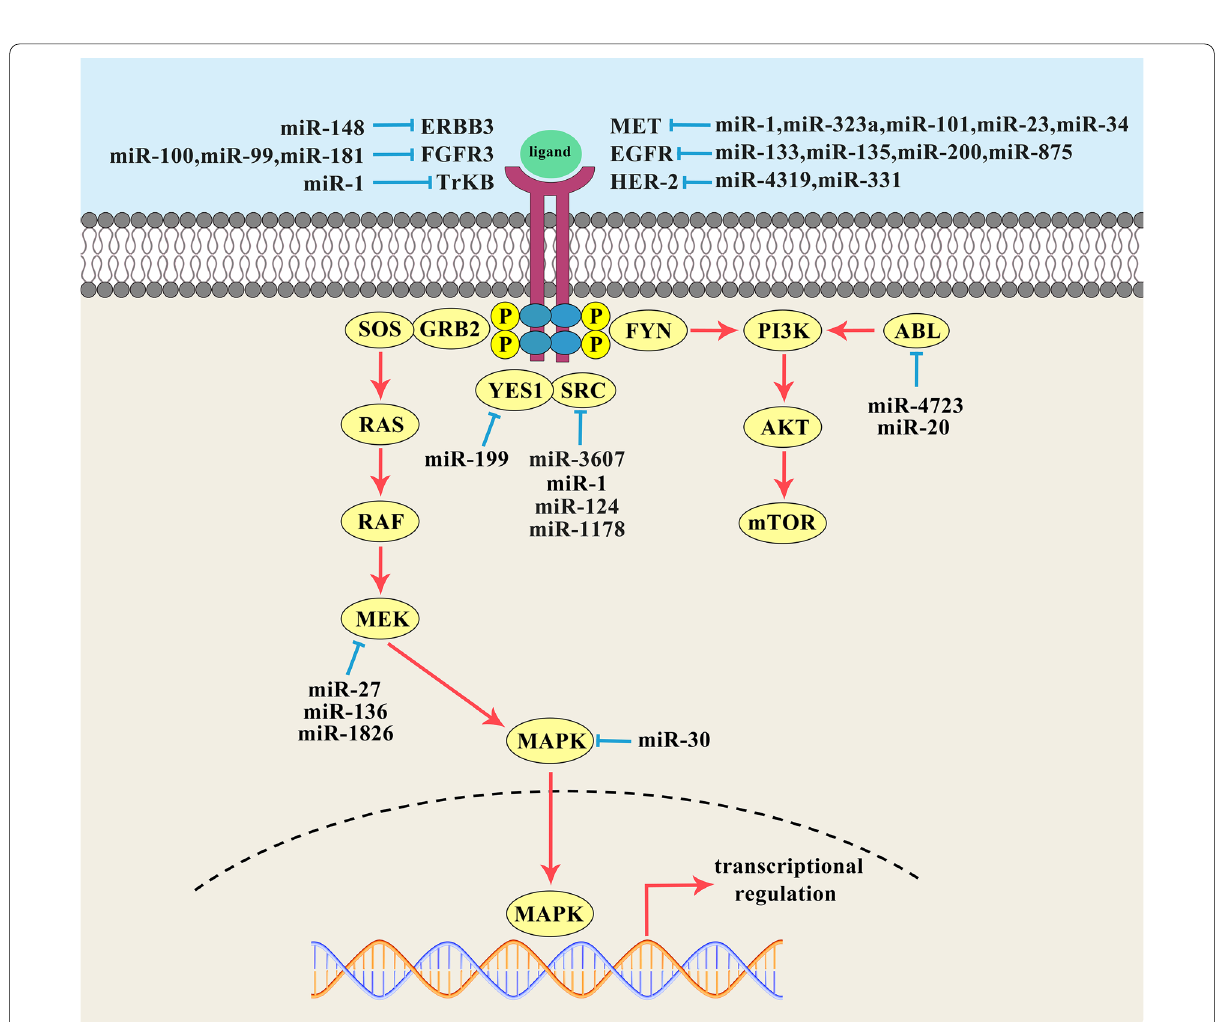
Fig. 1 All of the miRNAs–protein kinases interactions that are involved in prostate and bladder tumor